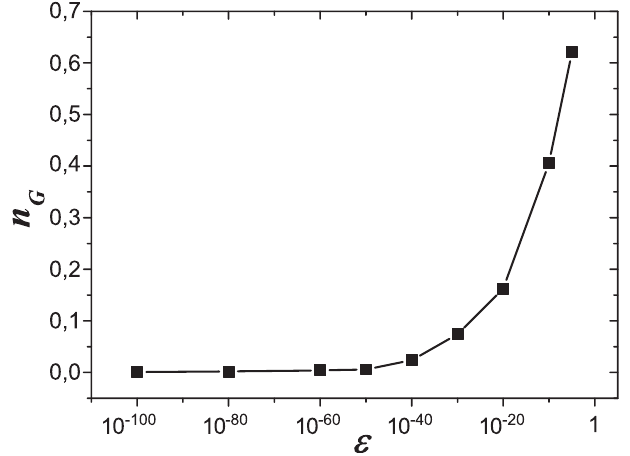
Figure 3. PHN Giant Component The fraction n G of nodes included in the largest connected component of the PHN is shown as a function of the homology cutoff e